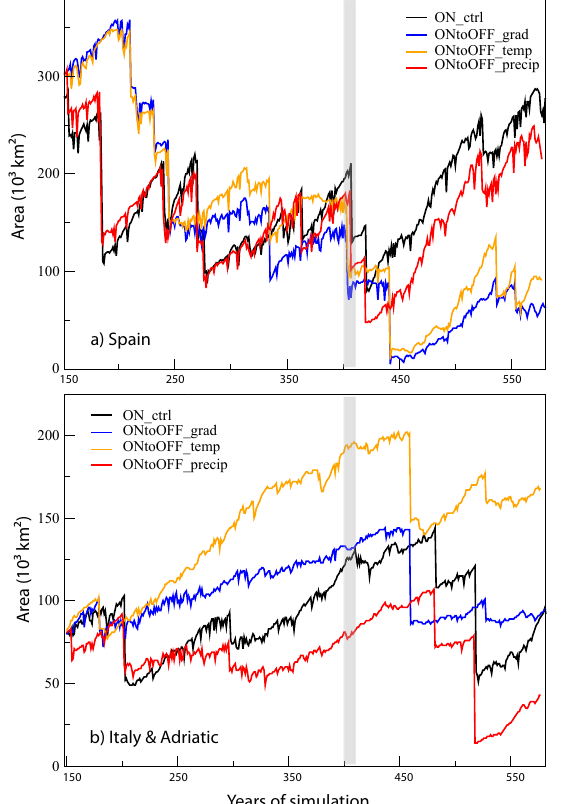
Fig. 14. Surface occupied by boreal broadleaf summergreen trees over (a) Spain and (b) Italy+Adriatic in ON ctrl (black), ON- toOFF grad (blue), ONtoOFF precip (red) and ONtoOFF temp (or- ange). The vertical grey bars indicate when the AMOC is fully col- lapsed in ONtoOFF